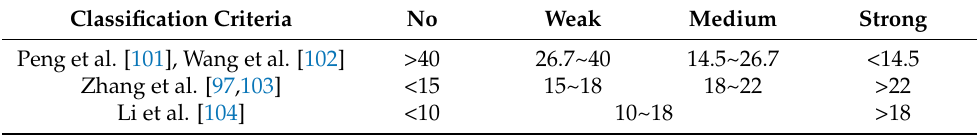
Table 2. Rockburst classification criteria based on brittleness coefficient B 1